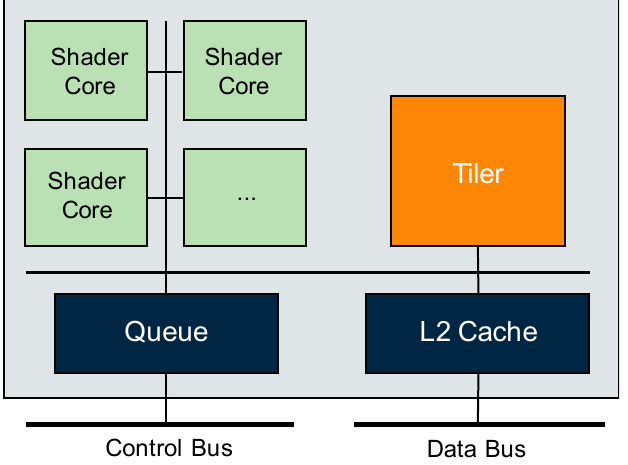
Figure 7. An abstract block diagram of Mali Midgard GPU architecture [16].